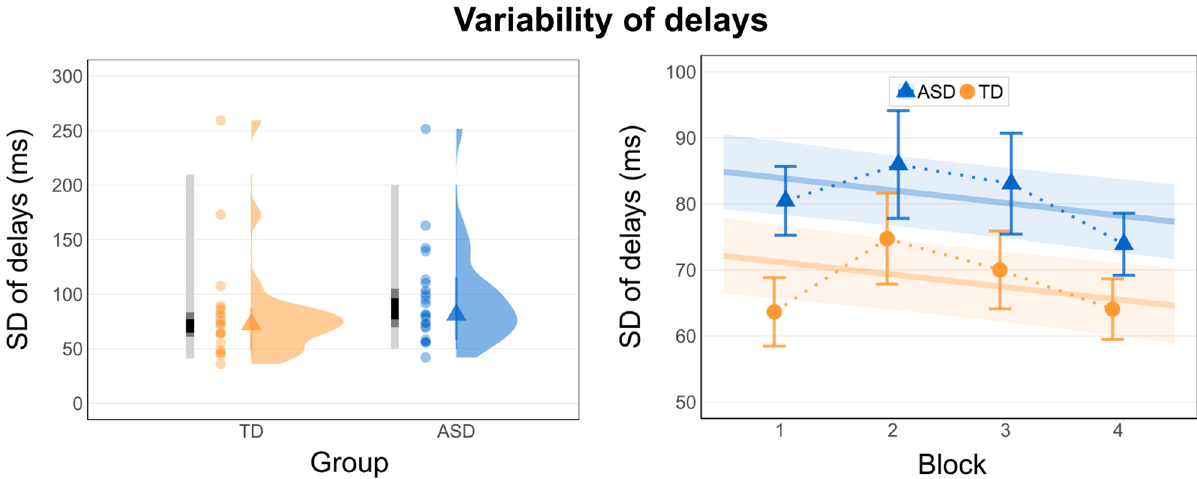
Figure 3. Within-subject SD of delays in both samples (left panel) and in both samples and experimental blocks (right panel). Left panel: Distribution of SD of delays aggregated for TD subjects in the comparison group in orange (left) and individuals with ASD in blue (right). Horizontally aligned density plots with medians (triangles), means per subject (point range), and the 25%, 50% and 95% colored confidence intervals (lightgrey = 95%; darkgrey = 50%; black = 25%). Right panel: SD of delays of the ASD group in blue (triangles) and comparison group in orange (circles), separately for the four experimental blocks with standard errors of the means as error bars. Estimated linear regression lines for ASD group (blue) and comparison group (orange) with confidence bands displaying the standard error of estimates (data in right panel is displayed after exclusion of extreme values in each